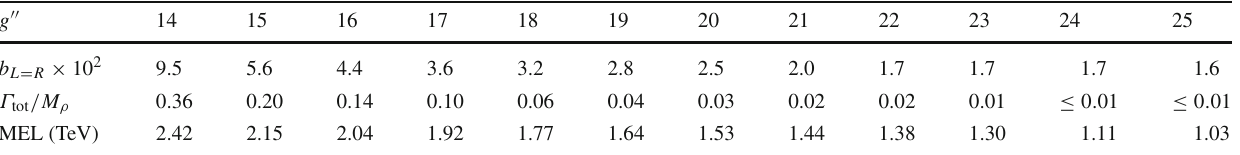
Table 4 The smallest tBESS resonance mass exclusion limits (MEL) within the interval | b L = R | ≤ 1 assuming b L = R ≡ b L = b R and p = 1 for various values of g (cid:2)(cid:2) . The second and third rows contain, respec-